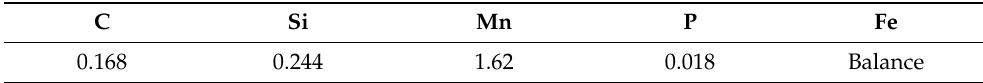
Table 1. Chemical compositions of AH36 marine steel